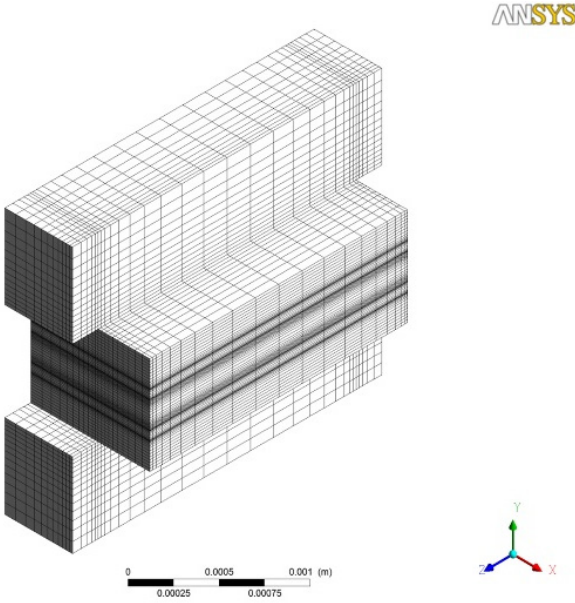
Figure 2. Computational mesh used in solving the mathematical model.